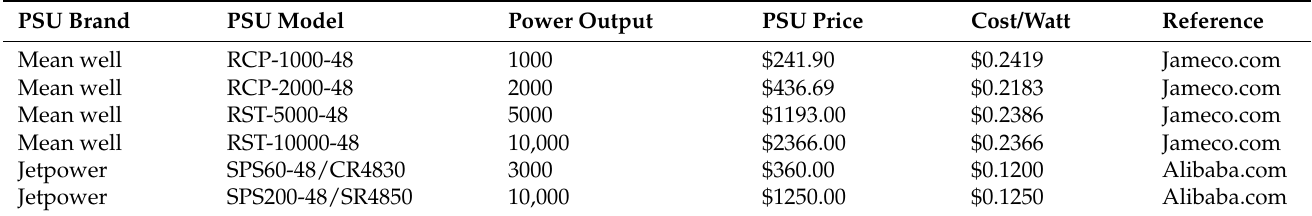
Table 4. Comparison of cost per watt for different PSU systems.